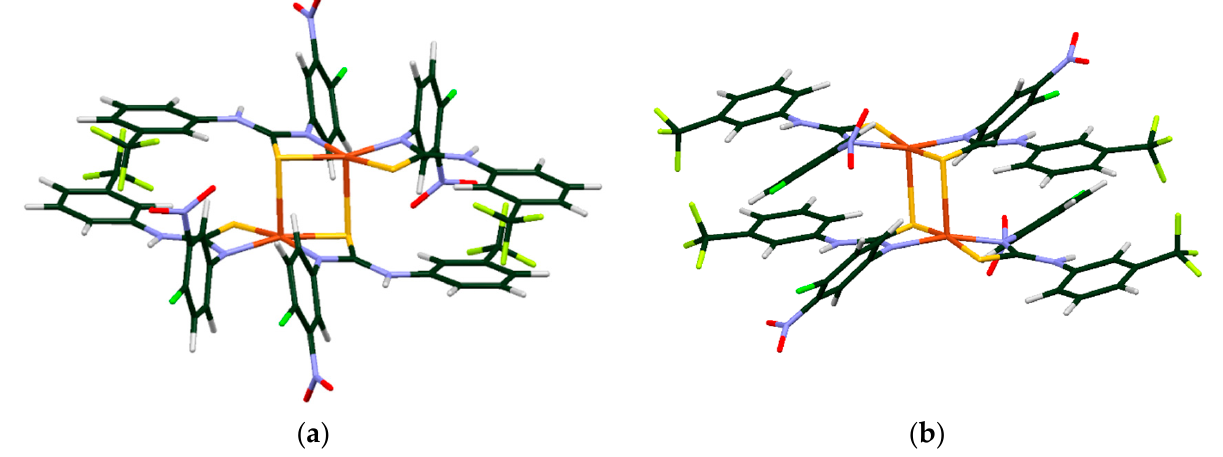
Figure 9. The structural dimeric models for representative Cu5 complex composed of ( a ) noncentrosymmetric and ( b ) centrosymmetric monomers. The dimer as a whole belongs to the C i group.